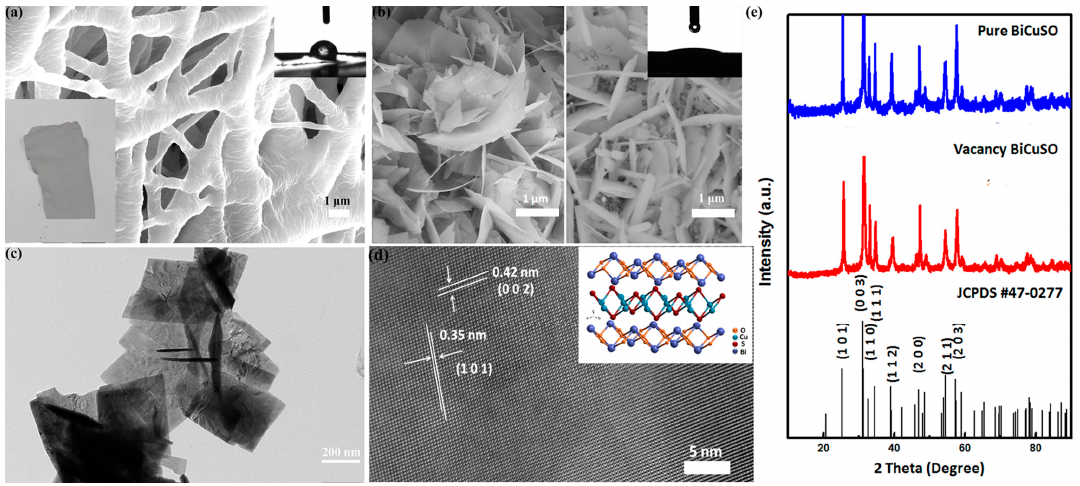
Figure 1. ( a ) SEM patterns of the PVDF/BiCuSO nanofibers; Inset: Left—Digital photograph of